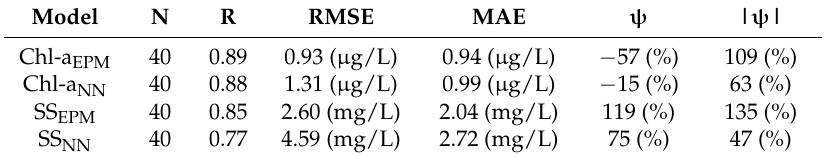
Table 5. Statistical performance measure of the Chl-a and SS concentration estimation models.